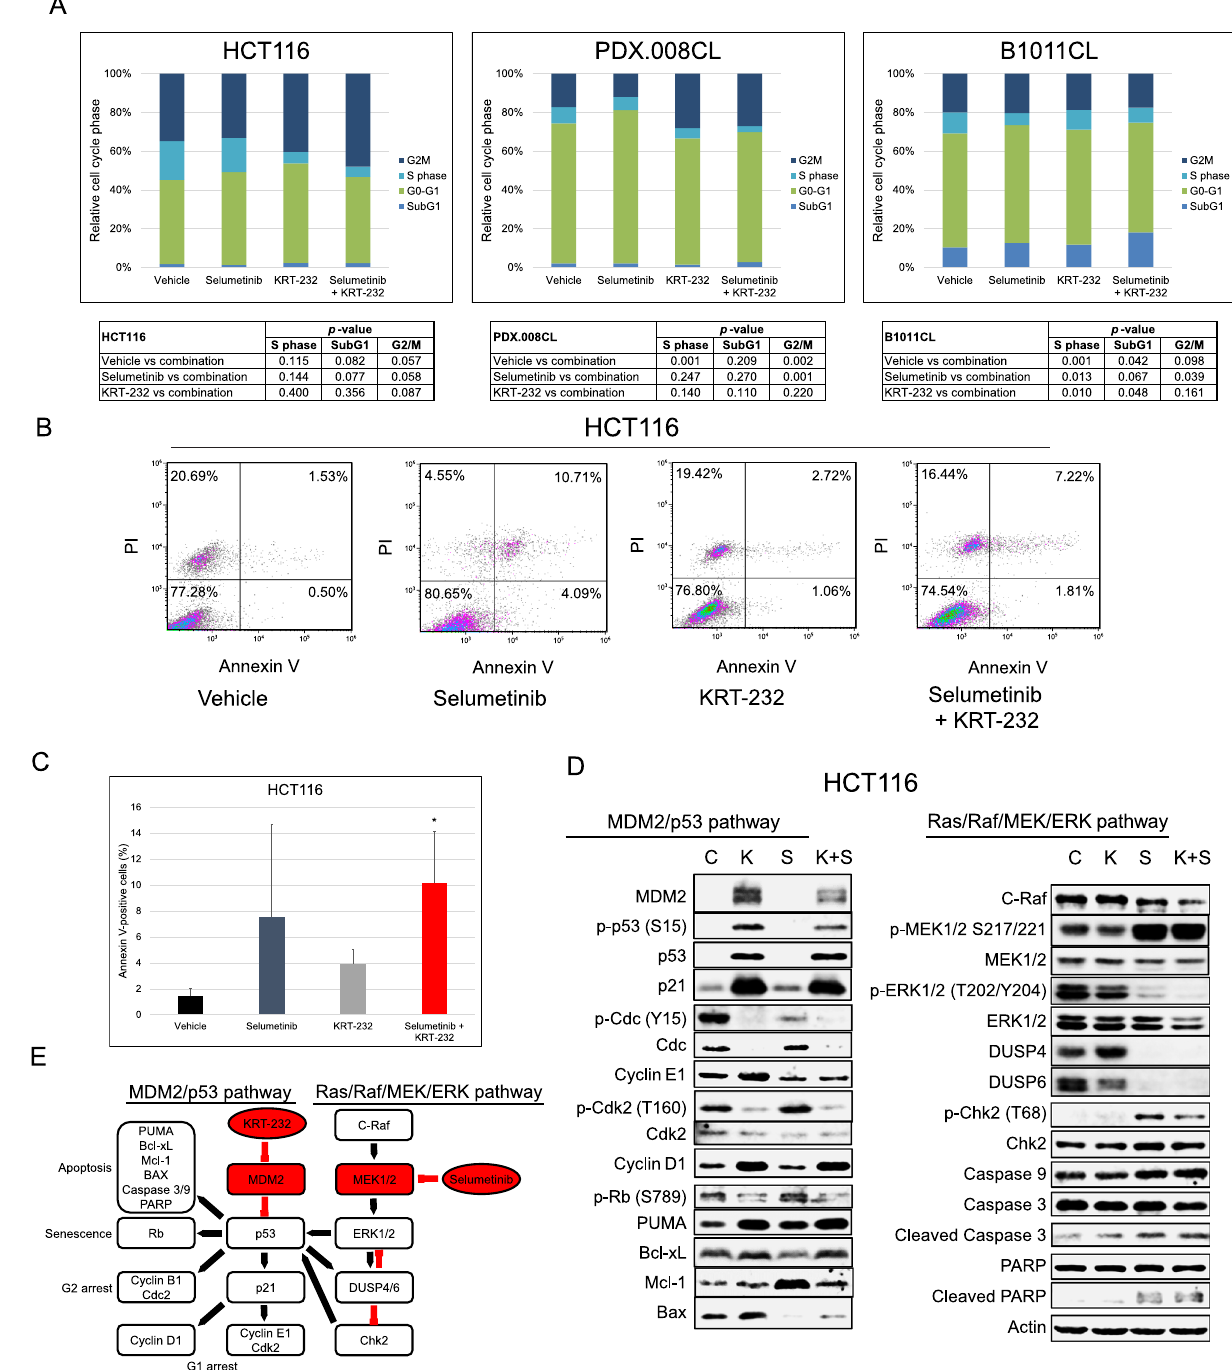
Figure 2. Effect of selumetinib combined with KRT-232 on cell cycle, apoptosis, and p53 and MAPK signaling. (A) Cell cycle analysis of two CRC cell lines (HCT116 and B1011CL) and one PTC cell line (PDX.008CL) after treatment for 24 h with vehicle, selumetinib (1 μM), KRT-232 (1 μM), or a combination of both. Percentages of cells in Sub-G1, G0-G1, S and G2/M phases of cell cycle are depicted. (B) Flow cytometry analysis of annexin-V positive cells in HCT116 colorectal cell line after treatment for 72 h by vehicle, selumetinib (1 µM), KRT-232 (1 µM) or combination of both. (C) Total percentage of annexin-V positive cell population shown in the graph after treatment for 72 h vehicle, selumetinib (1 µM), KRT-232 (1 µM) or combination of both. Values represent mean + /- SD. (*control vs combination, p = 0.046). (D) HCT116 CRC cells were treated with vehicle control (C), KRT-232 (1 μM, K), selumetinib (1 μM, S), or a combination of both (K + S) for 24 h. Cells were lysed and immunoblotting was performed using antibodies to identify changes in MDM2/p53 and MAPK pathways. Each blot had its loading control, in this panel one representative loading control (β-actin) was shown. The full-length blots are shown in Supplementary Fig. S2. (E) This illustration summaries the relation of antigens that were probed in (D)